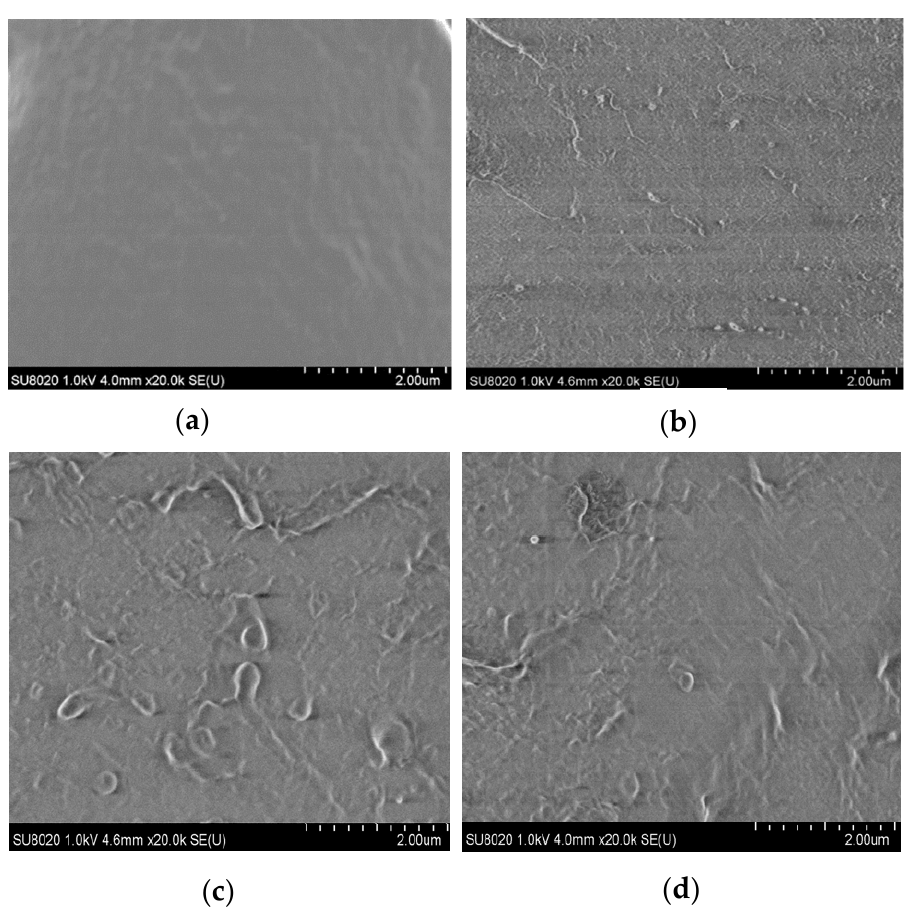
Figure 1. SEM patterns of ( a ) low density polyethylene (LDPE); ( b ) N5; ( c ) M5; ( d ) N3M2.